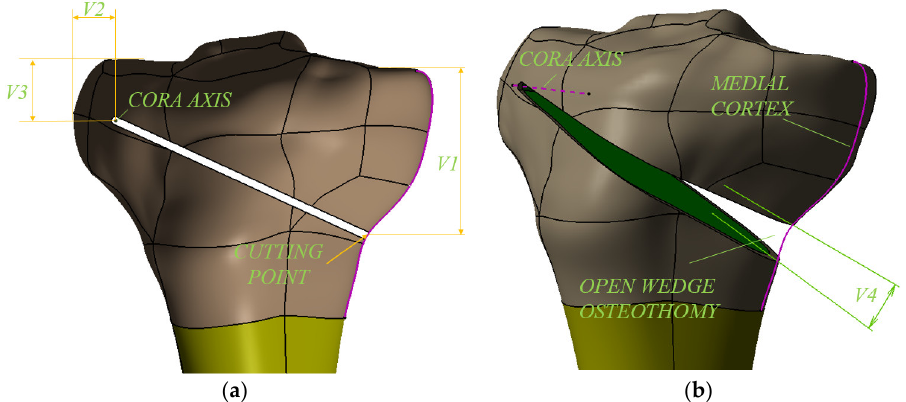
Figure 6. 3D modelling of the OWHTO—the parameters of the geometrical planning.